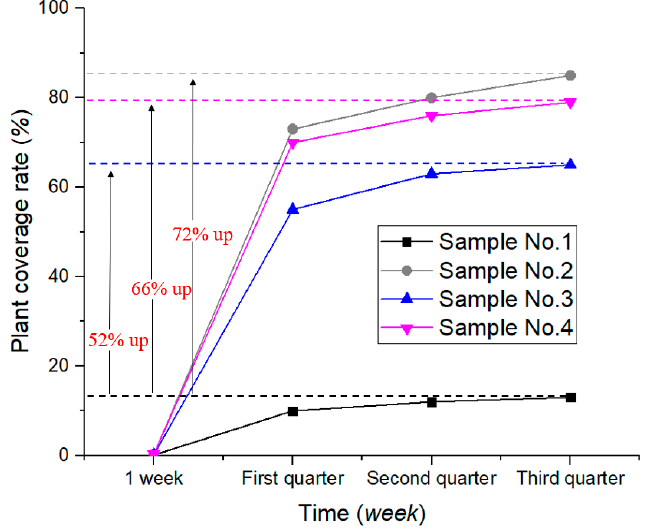
Figure 8. Plant coverage rate.